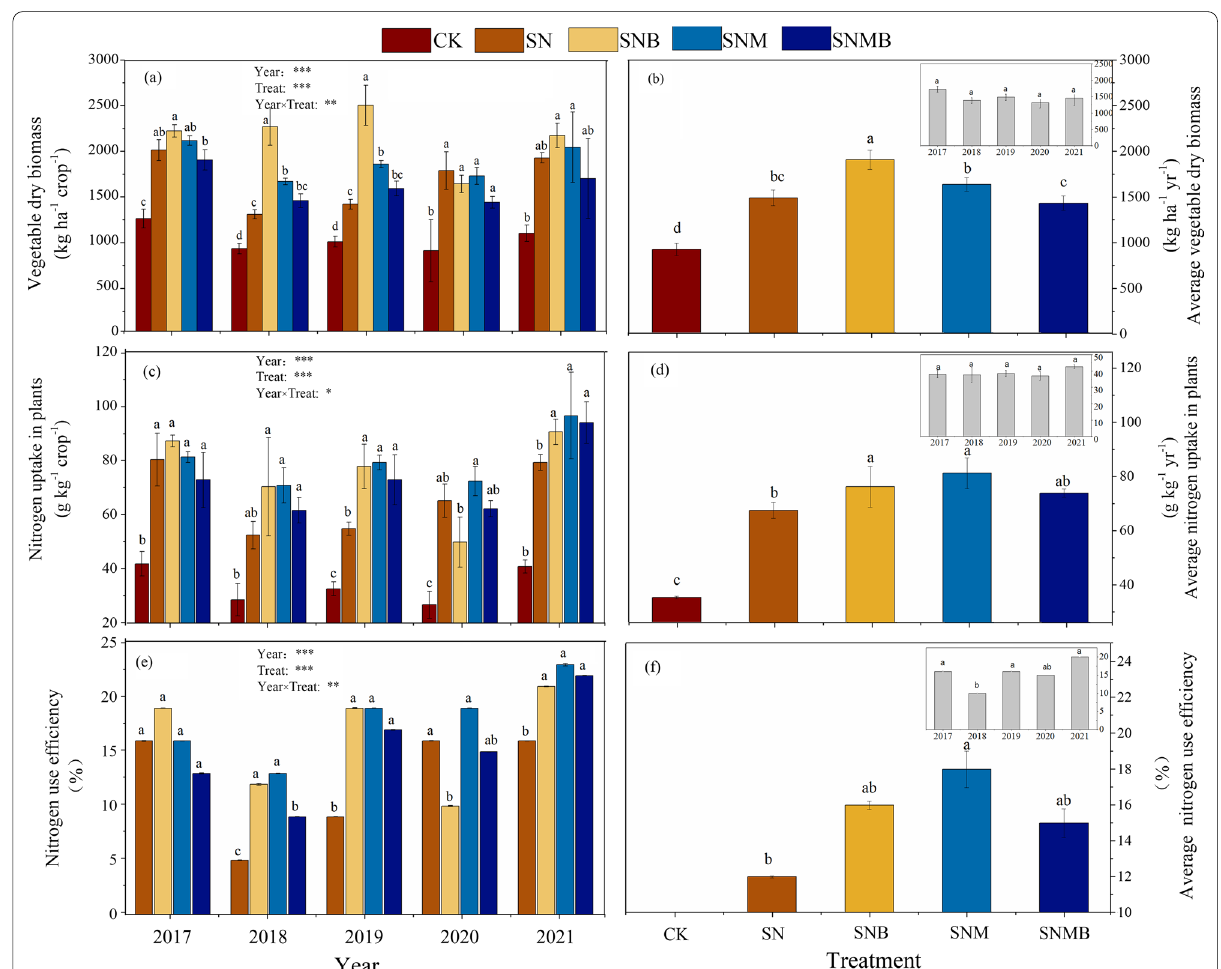
Fig. 3 Productivity and nitrogen use efficiency under different treatments in intensive vegetable production. The vegetable dry biomass ( a ), nitrogen uptake ( c ) and nitrogen use efficiency ( e ) under different treatments in intensive vegetable production, and ( b ), ( d ), ( f ) the average biomass, nitrogen uptake and nitrogen use efficiency of the treatments over a 5-year period. Different letters above the bars indicate significant differences among the different treatments (p < 0.05). Bars indicate the standard deviation. Two-way ANOVA results for vegetable biomass and nitrogen uptake in plants of year, treatment and their interactions (year treatment) are also shown in the figure. *, ** and *** indicate significant × differences at the p < 0.05, p < 0.01 and p < 0.001 levels,